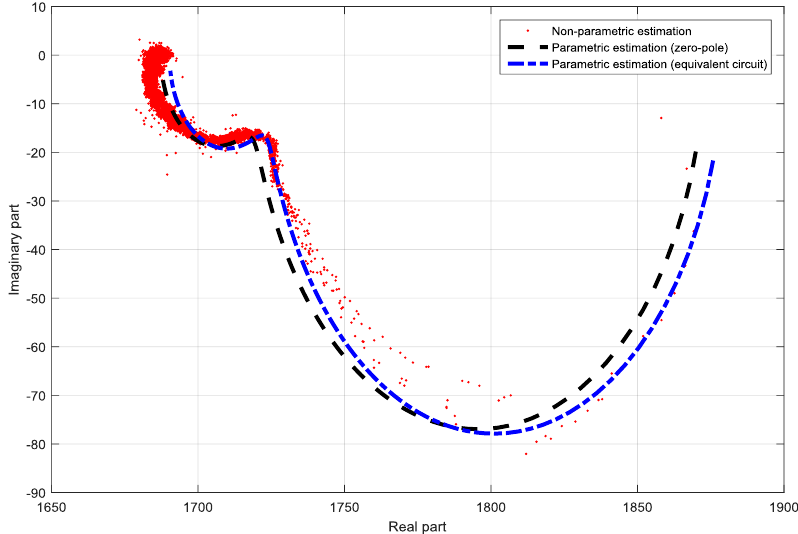
Figure 4. Comparison of the non-parametric and parametric TF identifications of a standard DSSC in Nyquist-diagram.